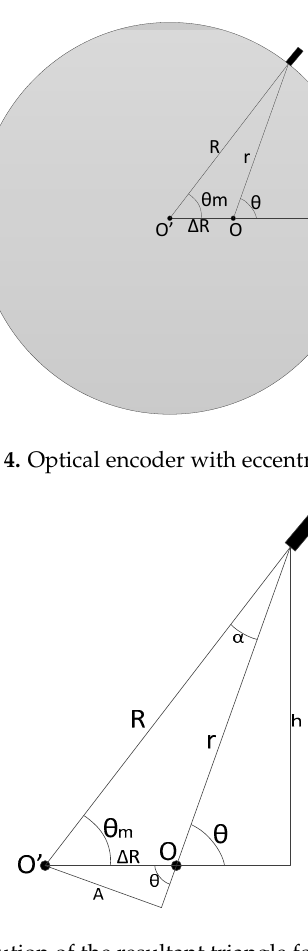
Figure 5. Resolution of the resultant triangle for eccentricity bias.